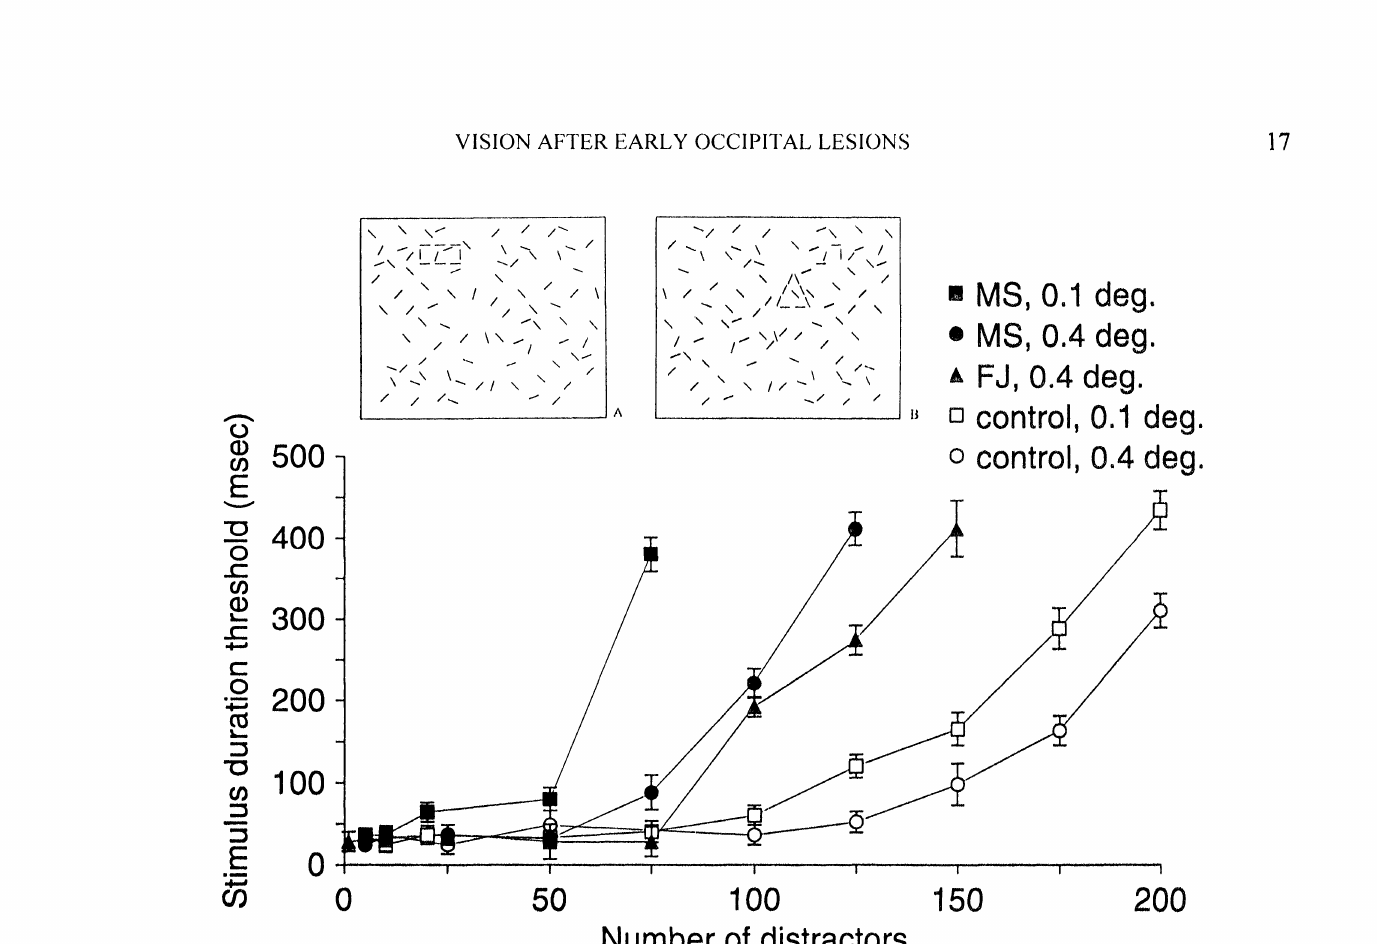
Fig. 6: Results of the ’shape identification tasks in MS and FJ. The subject had to identify the shape (rectangle in A, triangle in B) presented among the distractors. We measured the minimal presentation duration for reliable identification, for two different segment lengths, and different numbers of distractors. We plotted the presentation duration as a function of the number of